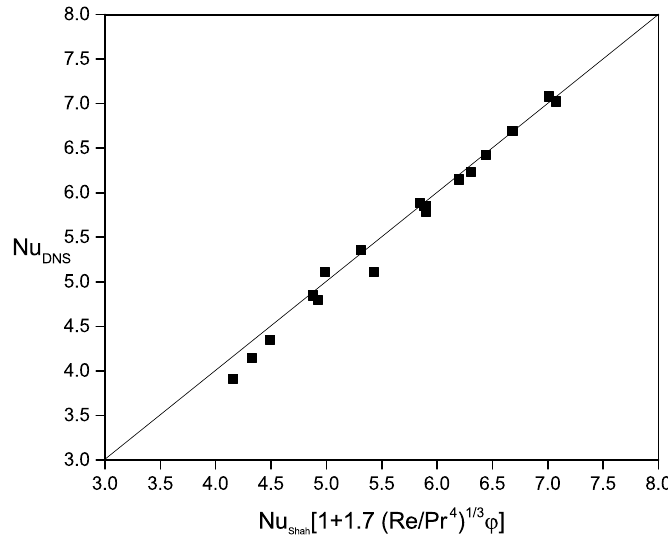
Figure 15. Verification of Equation